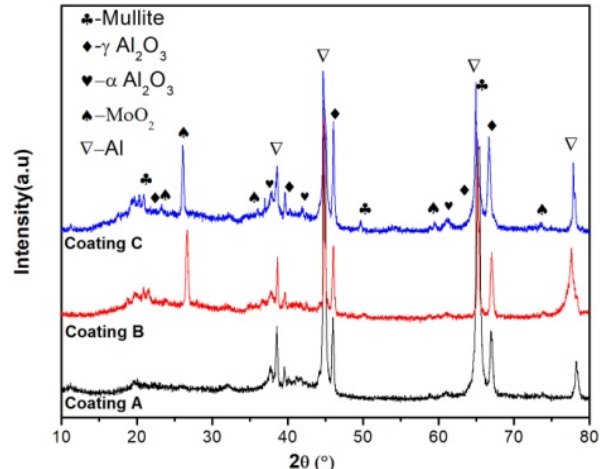
Figure 3. XRD patterns of the MAO